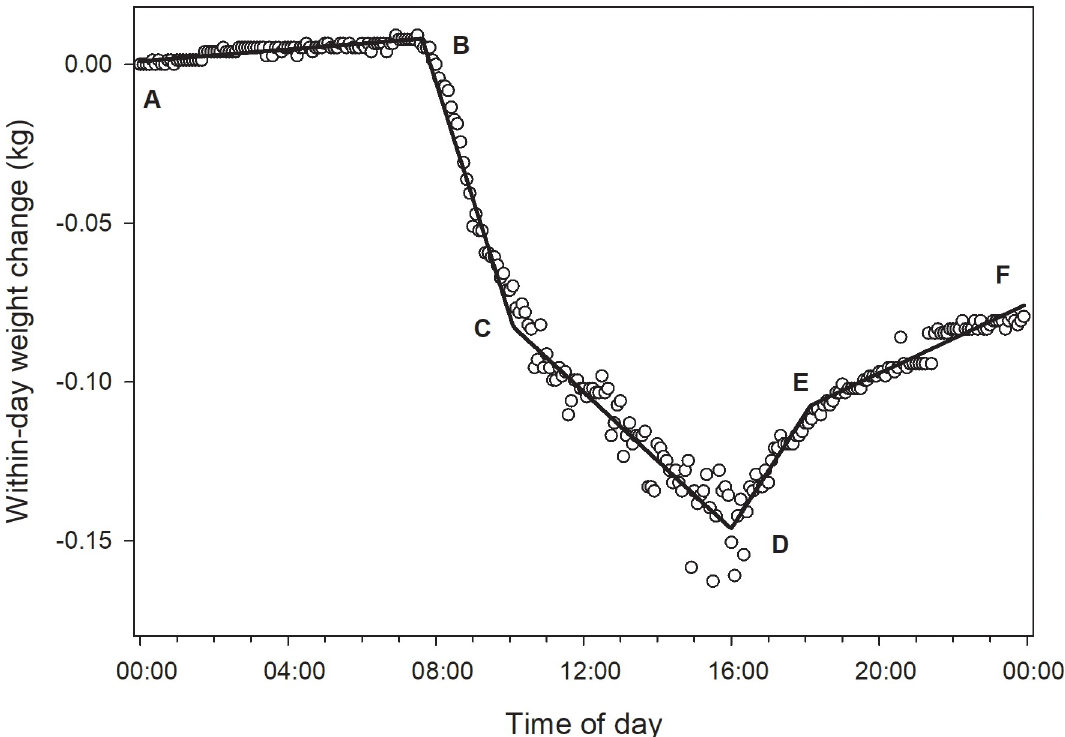
Fig 1. Within-day hive weight data and associated fitted piecewise regression. Data were obtained from a hive in the control group on 24 November 2017 during a forage dearth. 1.Point A: First weight measure at midnight or shortly thereafter; 2.Segment AB: Inactive period in the early morning; hive weight change is likely due to bee respiration and changes in the moisture content of nectar, pollen and wooden hive parts; 3.Point B: Bee departure at beginning of active period, usually close to dawn - 1 st break point; 4. Segment BC: Active period usually showing hive weight loss due to far greater numbers of departing bees compared to returning bees- “departing slope”; 5.Point C: Point at which rate of hive weight loss changes, likely due to higher ratio of returning bee mass compared to departing bee mass; 6.Segment CD: Continued increase in hive weight due to forager return; 7.Point D: Point at which mass of returning foragers, including nectar and pollen as well as bee weight loss due to respiration, equals the mass of departing bees plus weight loss due to drying and respiration in the colony; 8.Segment DE: Increasing hive weight due to returning foragers; 9.Point E: Return of bees to the hive around dusk is completed–last break point; 10.Segment EF: Inactive period with hive weight change driven mainly by respiration and changes in ambient humidity–usually close to parallel with segment AB; 11.Point F: Last weight measure just before